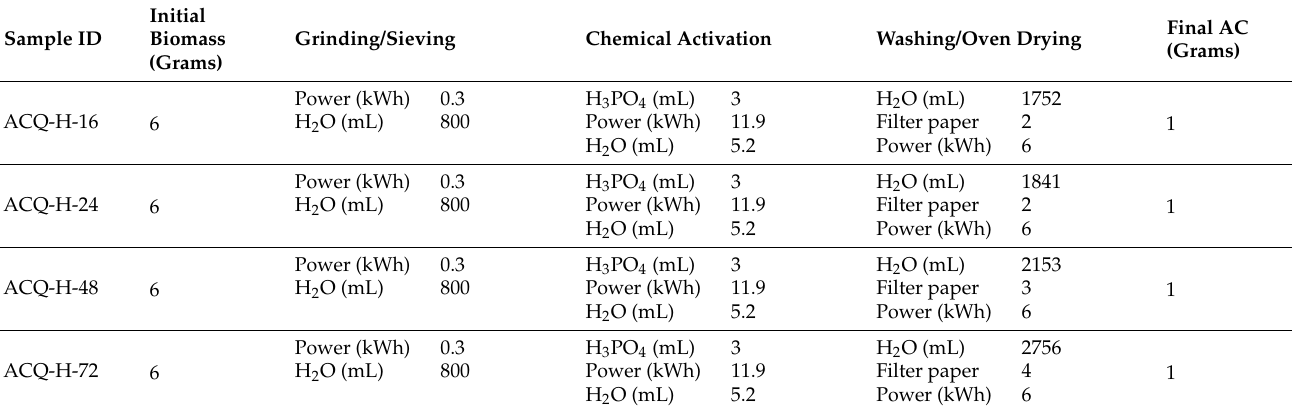
Table 1. Life cycle inventory of waste leaves of Quercus alba conversion to activated